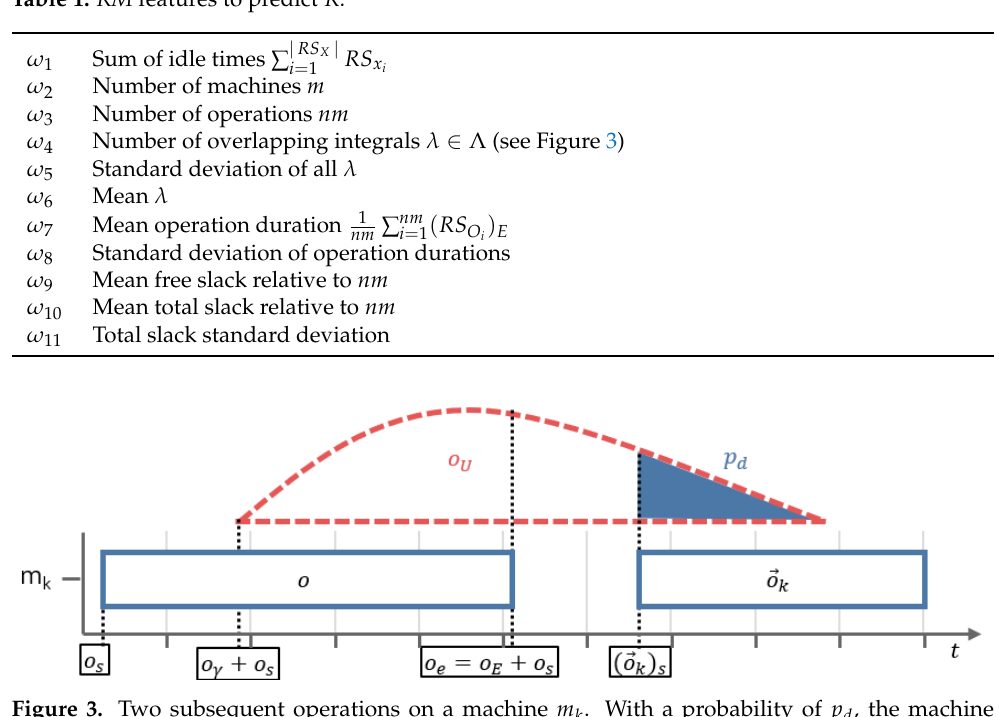
Table 1. RM features to predict R .